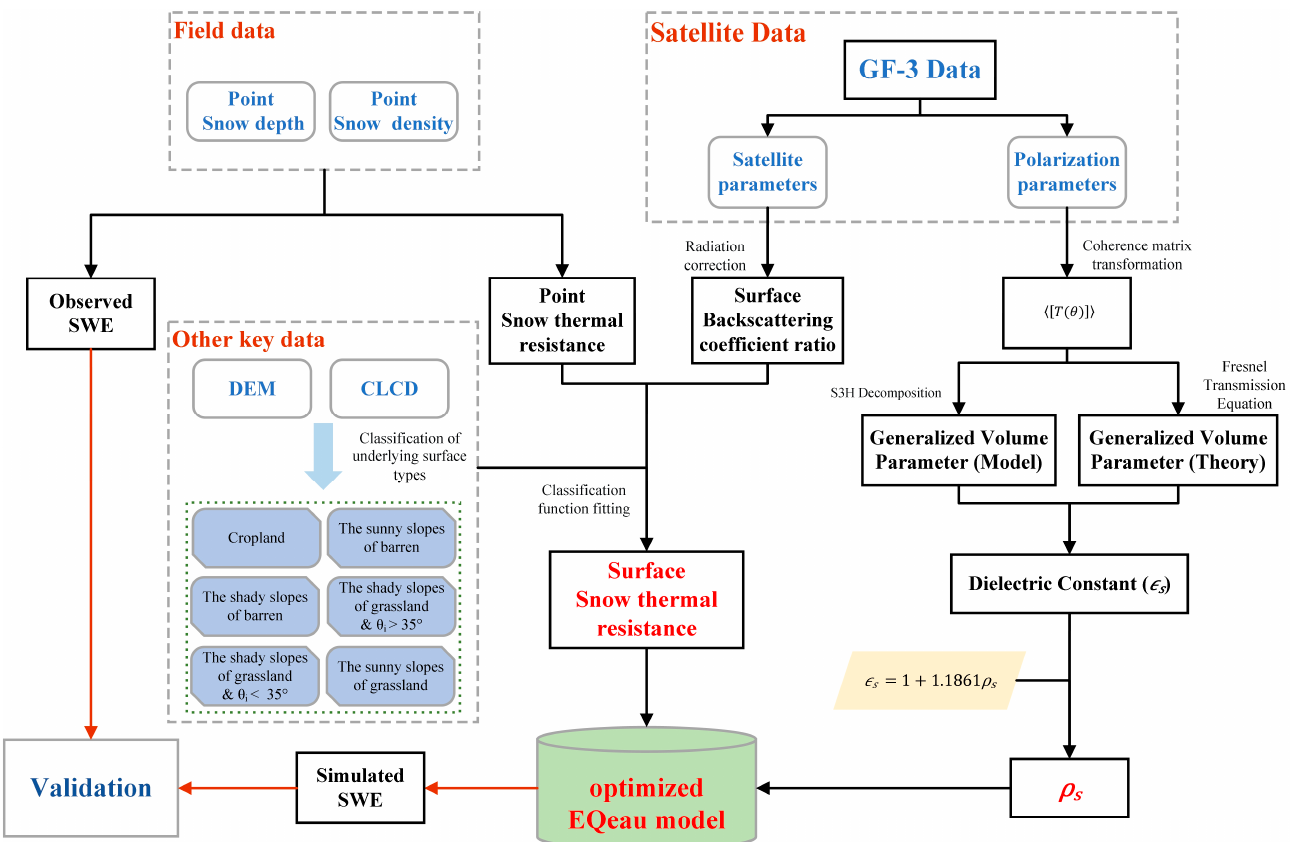
Figure 2. Flowchart of the optimized SWE inversion model for GF-3.